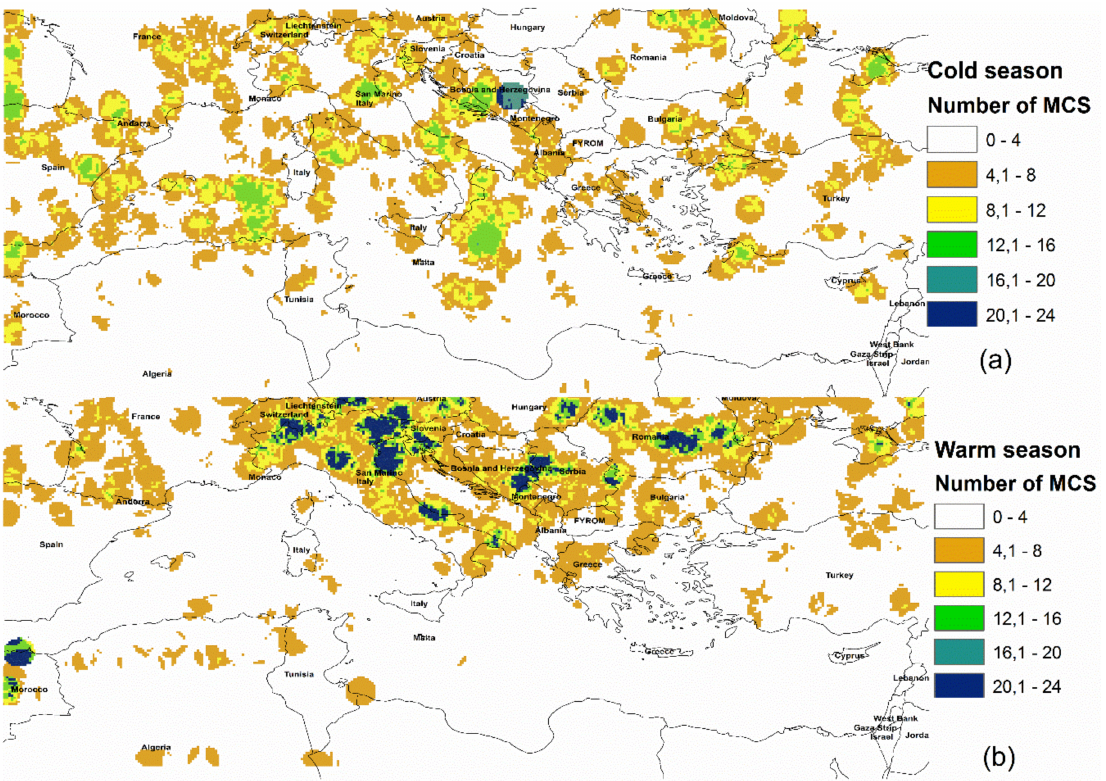
Figure 4. Spatial density of occurrence for the MCSs with at least one CC localmax event during ( a ) cold season; ( b ) warm